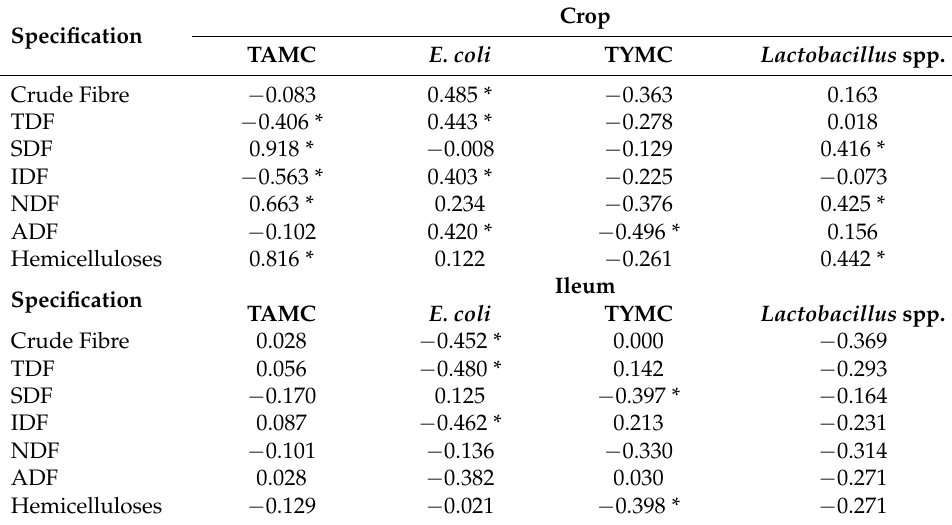
Table 8. Correlation between dietary/crude fibre in feed and count of microorganisms in crop of broiler chickens ( n =